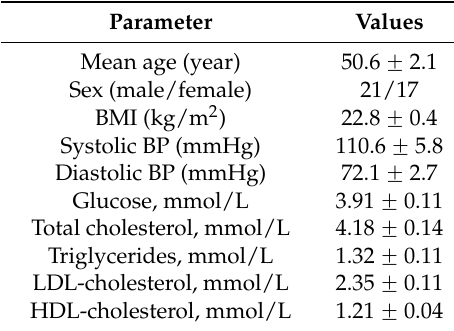
Table 1. Baseline demographic and clinical